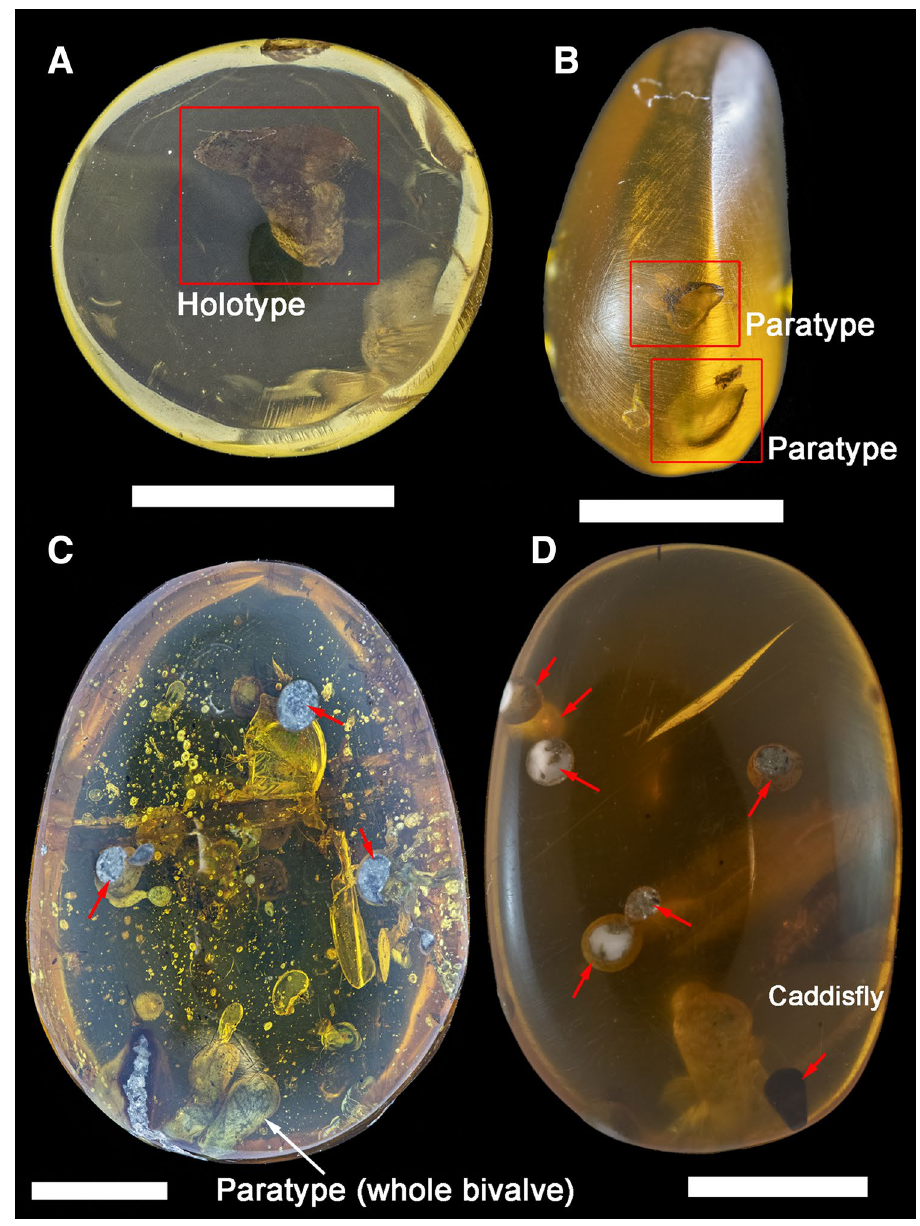
Figure 1. Lower Cenomanian Kachin amber samples with specimens and borings of † Palaeolignopholas kachinensis gen. & sp. nov. from northern Myanmar used in this study. ( A ) RMBH biv1115 (frontal view with the holotype). ( B ) RMBH biv1101 (lateral view with two paratypes and a shell fragment). ( C ) RMBH biv1116 (frontal view with the fossilized paratype). ( D ) RMBH biv1100 (frontal view with borings). The red frames indicate position of the type specimens (holotype and some paratypes). The red arrows indicate bivalve borings. Scale bars = 5 mm. (Photos: Ilya V.